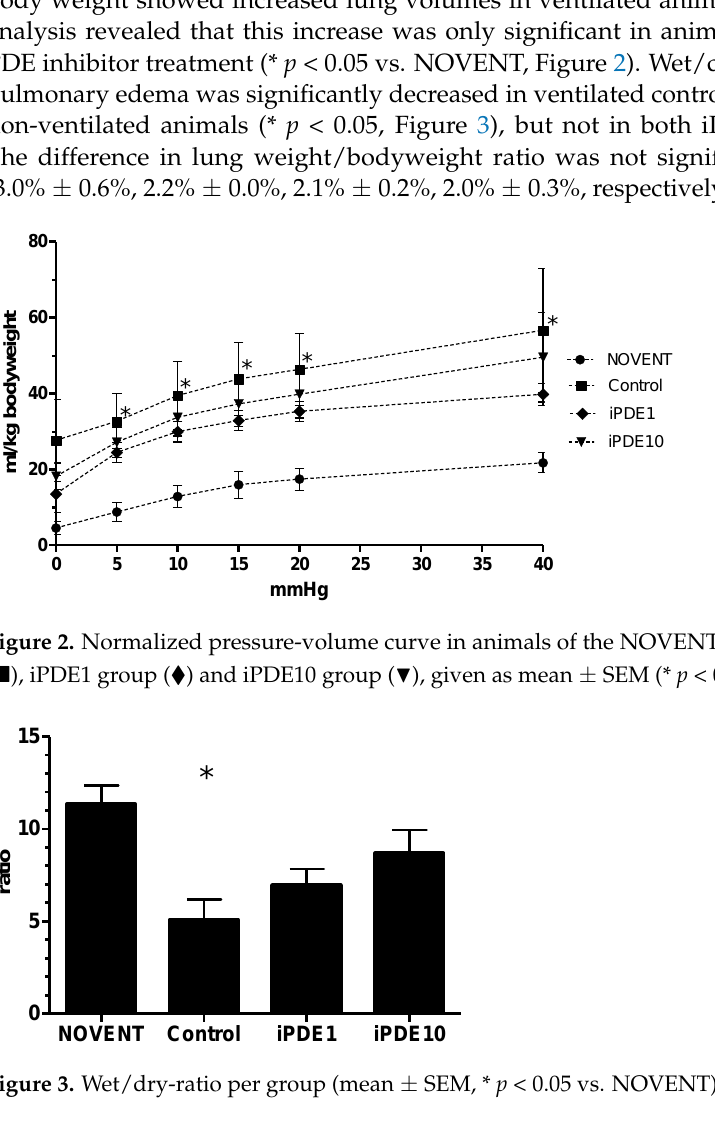
Figure 1. Parameters of oxygenation, including ( a ) Oxygenation index (OI), ( b ) alveolar-arterial gra- dient (AAG), ( c ) Horowitz score (PF), ( d ) alveolar partial pressure of oxygen (P A O 2 ), and parameters of ventilation including ( e ) compliance, ( f ) ventilator efficiency index (VEI), during the course of the experiment in animals in control group ( ■ ), iPDE1 group ( ♦ ) and iPDE10 group ( ▲ ), given as mean ± SEM.